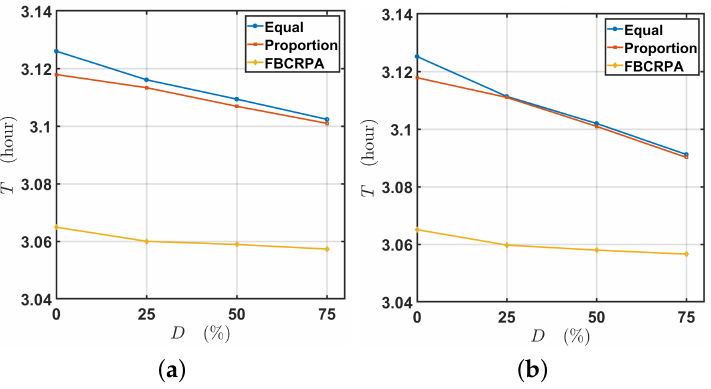
Figure 2. Performance comparison of three schemes. ( a ) M = 0.5, B = 360. ( b ) M = 1, B =